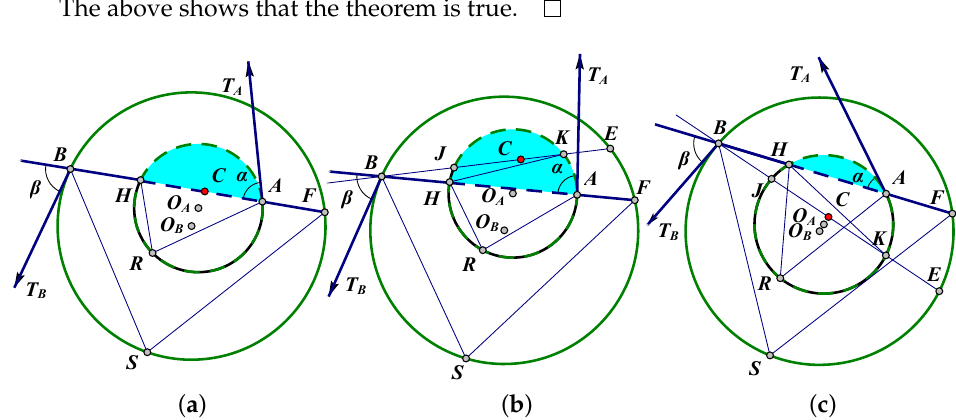
Figure 4. C is ( a ) on the chord AH ; ( b ) in the shaded region; ( c ) out of the shaded region.